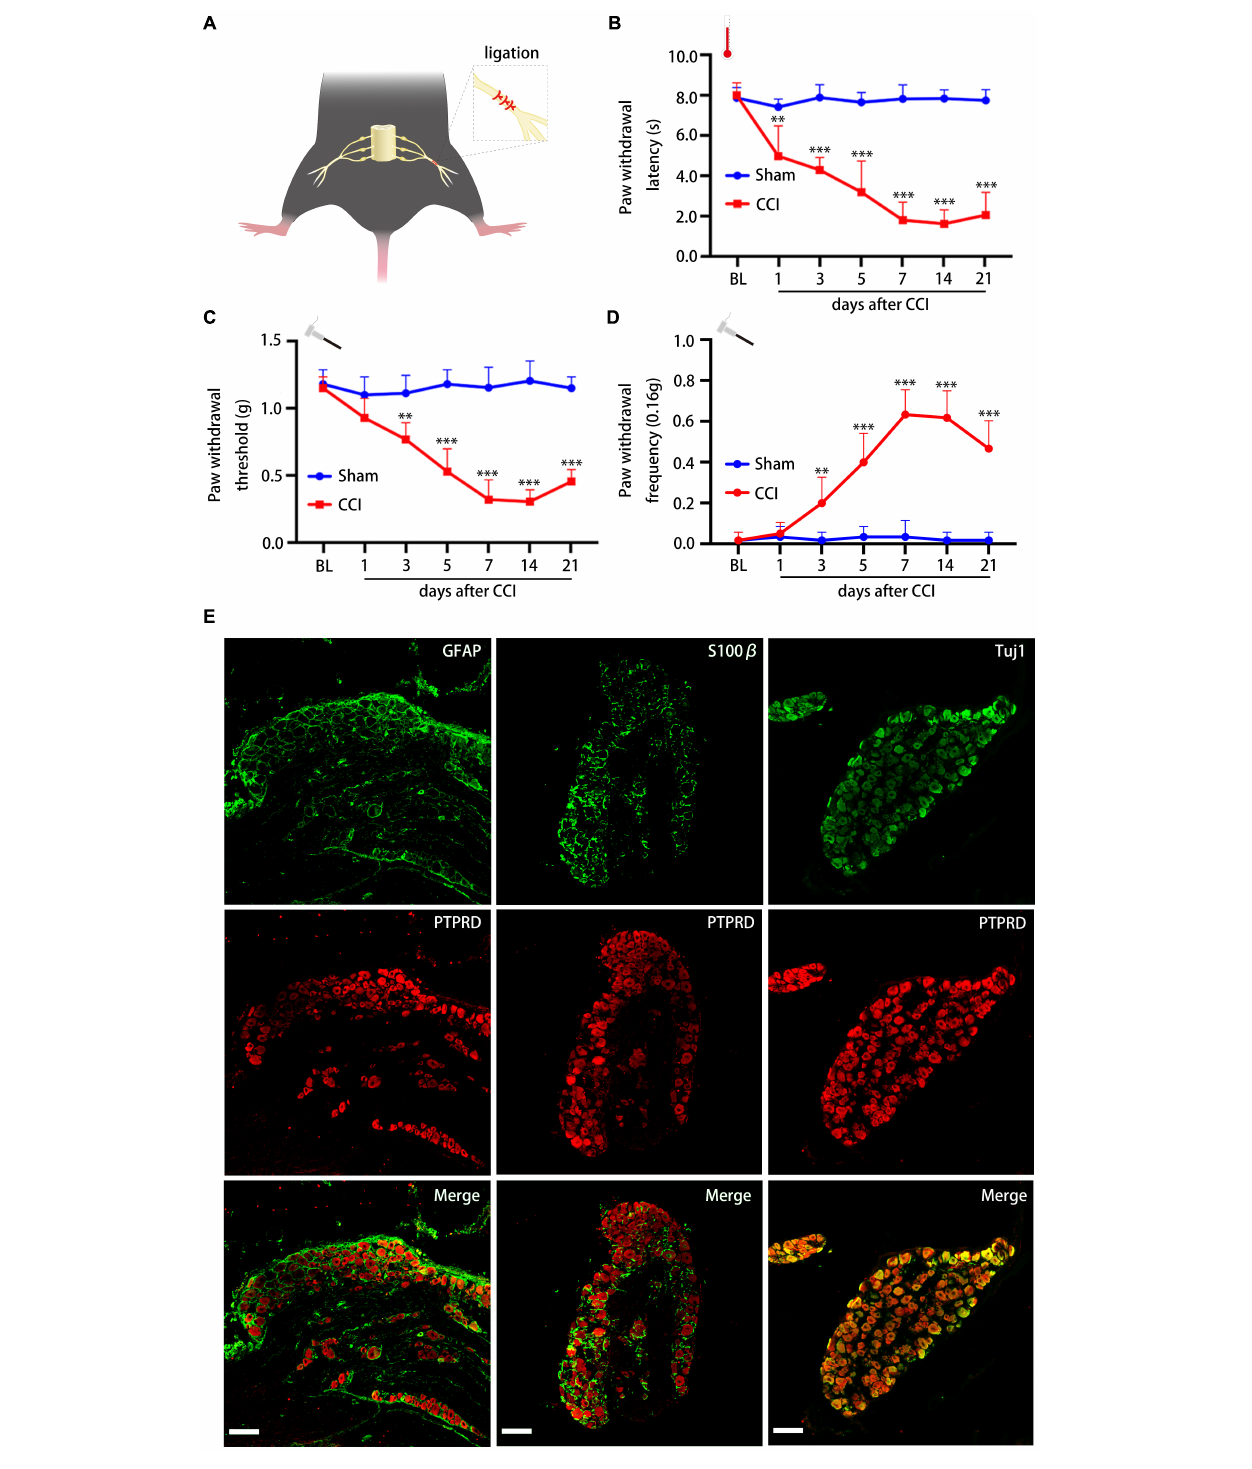
FIGURE 1 | Chronic constriction injury induces neuropathic pain and PTPRD is expressed in DRG neurons. (A) Schematic overview of the CCI-induced neuropathic pain model. (B–D) Paw withdrawal latency (PWL), paw withdrawal threshold (PWT), and paw withdrawal frequency (PWF) before the surgery (BL) and 1, 3, 5, 7, 14, and 21 days after CCI. N = 6 mice per group, ∗∗ p < 0.01, ∗∗∗ p < 0.001. (E) Representative images of PTPRD co-staining with GFAP, S100 β , or Tuj1 in DRG sections 7 days after CCI. Scale bars, 100 µ m. Statistical comparisons were performed by two-way ANOVA with Tukey’s post hoc test (B–D) .